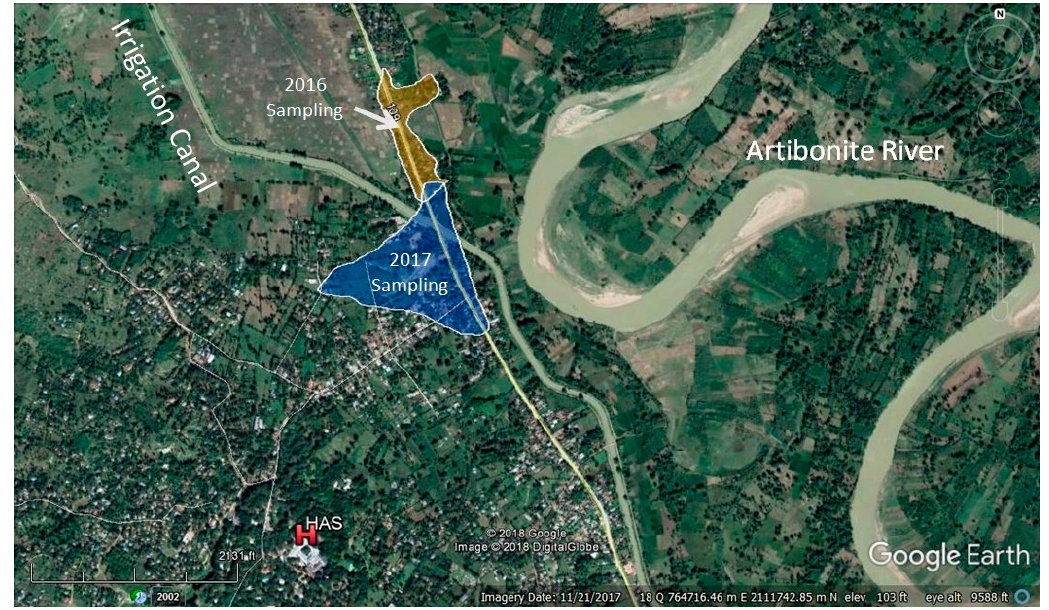
Figure 4. Hand–dug well sampling areas in 2016 and 2017.